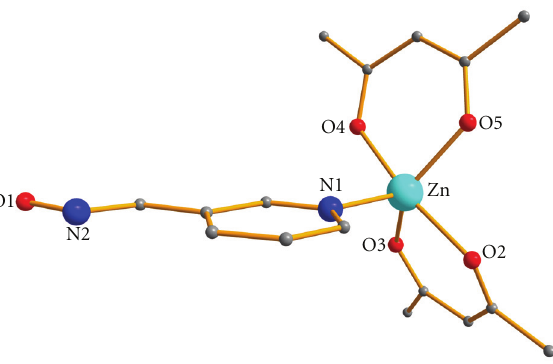
Figure 1: Partially labeled plot of the molecular structure of 1 · H 2 O. H atoms and the solvate H 2 O molecule have been omitted for clarity.